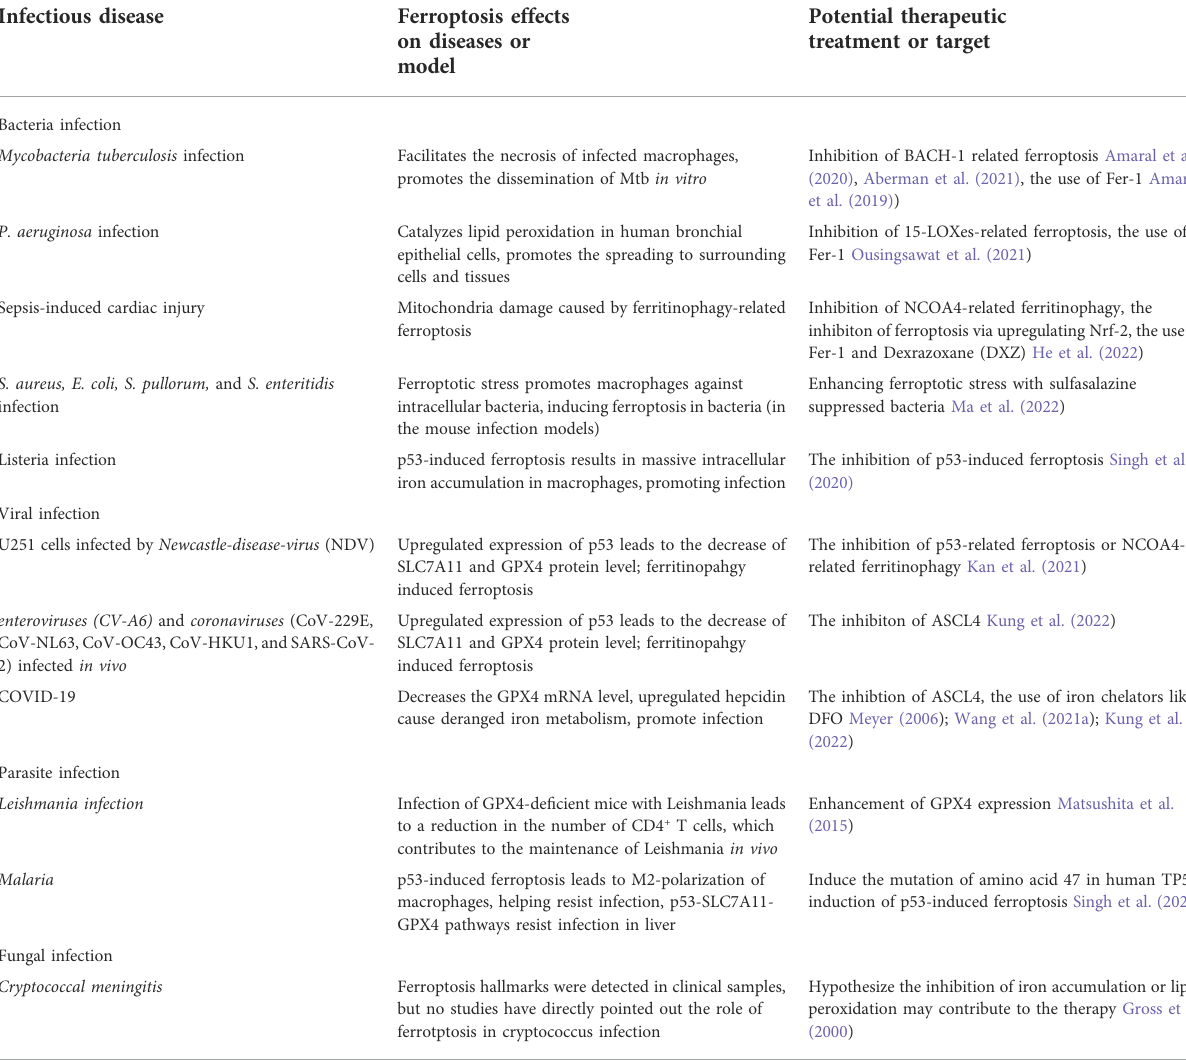
TABLE 3 Summary of the relationships between ferroptosis and infectious diseases and potential therapeutic target or